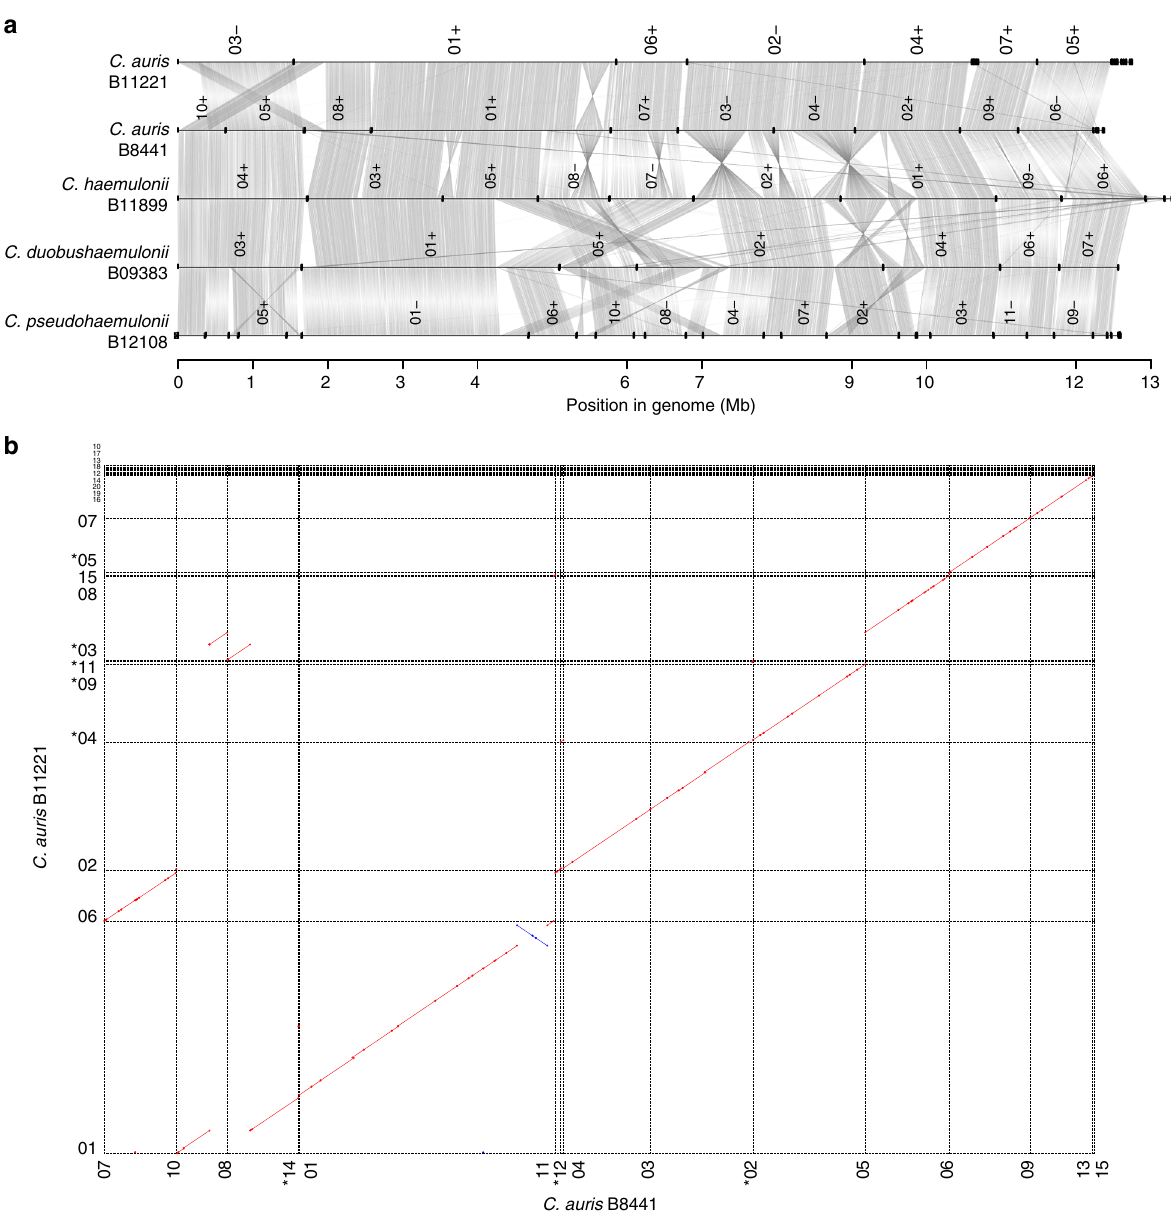
Fig. 1 Whole genome conservation, structure, and synteny. a Genome wide gene synteny among Candida auris , C. haemulonii , C. duobushaemulonii , and C. pseudohaemulonii . To determine synteny regions of conserved gene order, we identi fi ed orthologs between these isolates and then plotted chains of orthologs (gray lines). Isolate names are shown to the left of their genomes, which are represented by horizontal black lines, with vertical lines indicating scaffold borders, and their identi fi ers listed above ( + / − = orientation). b Shared synteny regions based on whole genome alignments between C. auris B8441 and B11221. Asterisk refers to scaffolds in reverse